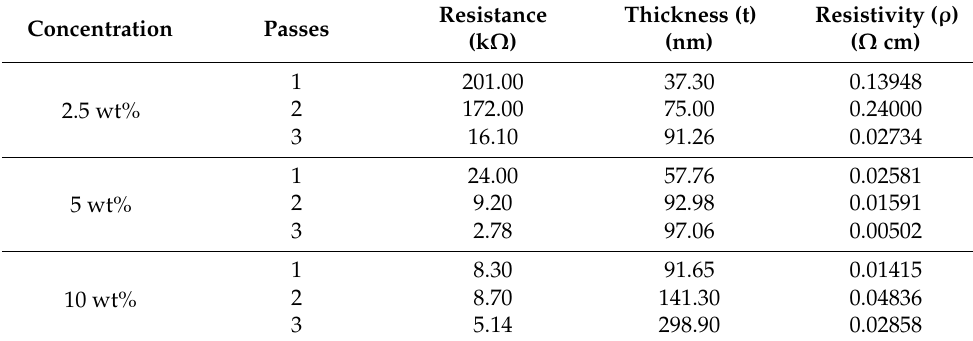
Table 2. The summarised results of the resistivity values for the f –rGO printed samples. Concentration